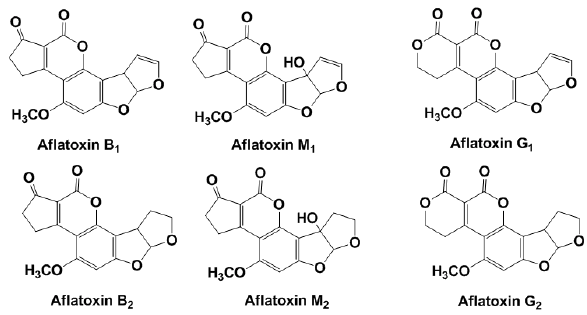
Figure 1. Chemical structures of common aflatoxins.